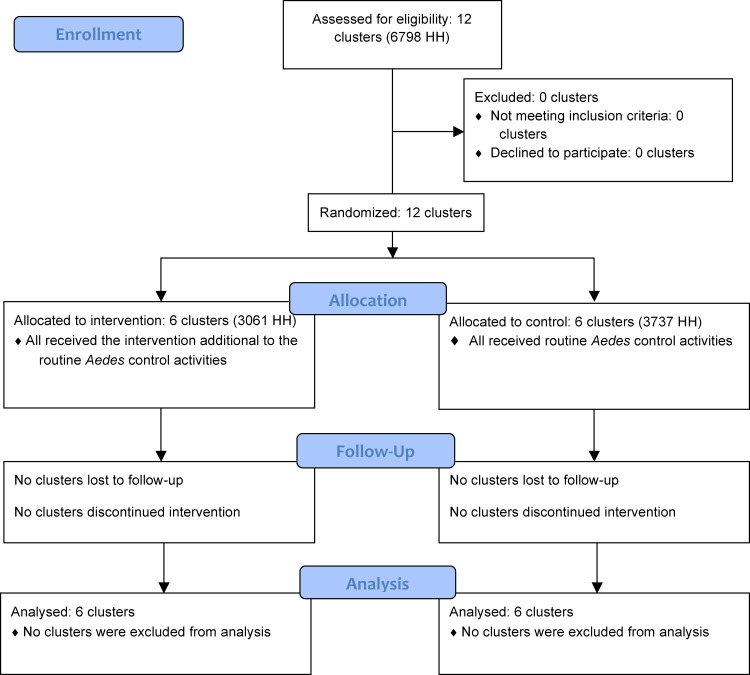
CONSORT flowchart.